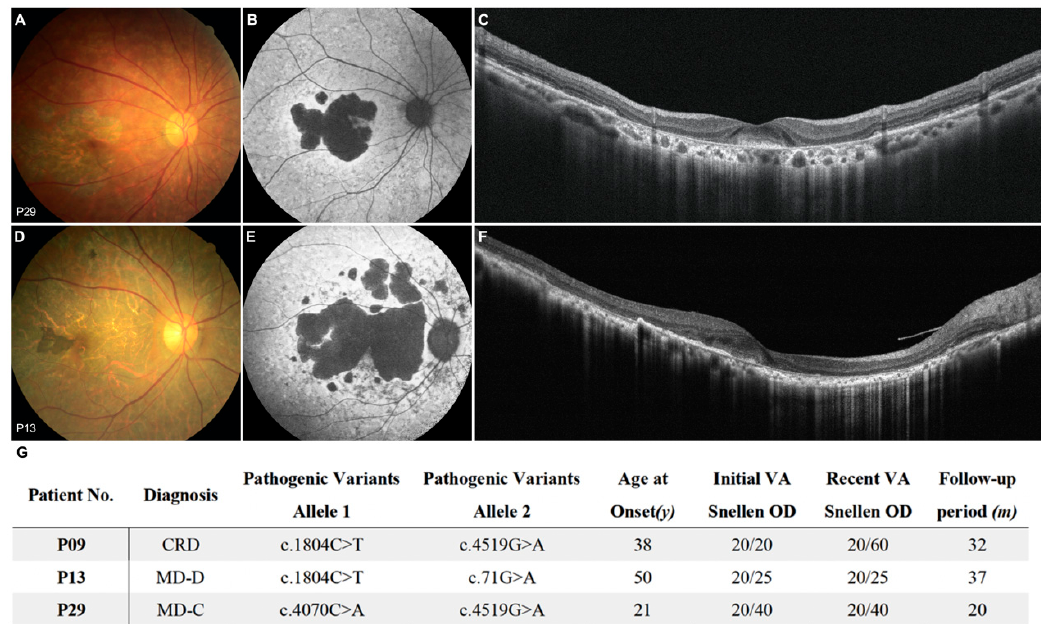
Figure 5. Foveal sparing phenotype. ( A ) P29 with macular chorioretinal atrophy sparing central fovea, ( B ) well demarcated patchy definite decreased autofluorescence (DDAF) with relative hyperautofluorescence in the foveal area, ( C ) loss of the photoreceptor and ellipsoid zone at the parafoveal area with a preserved structure in the central fovea. ( D ) P13 has diffuse chorioretinal atrophy sparing fovea with pigmentation, ( E ) multiple patchy DDAF without foveal involvement and heterogeneous background, ( F ) Diffuse loss of the photoreceptor and ellipsoid zone but a relatively preserved fovea. ( G ) Demographic data of three patients with foveal sparing phenotype in fundus autofluorescence.